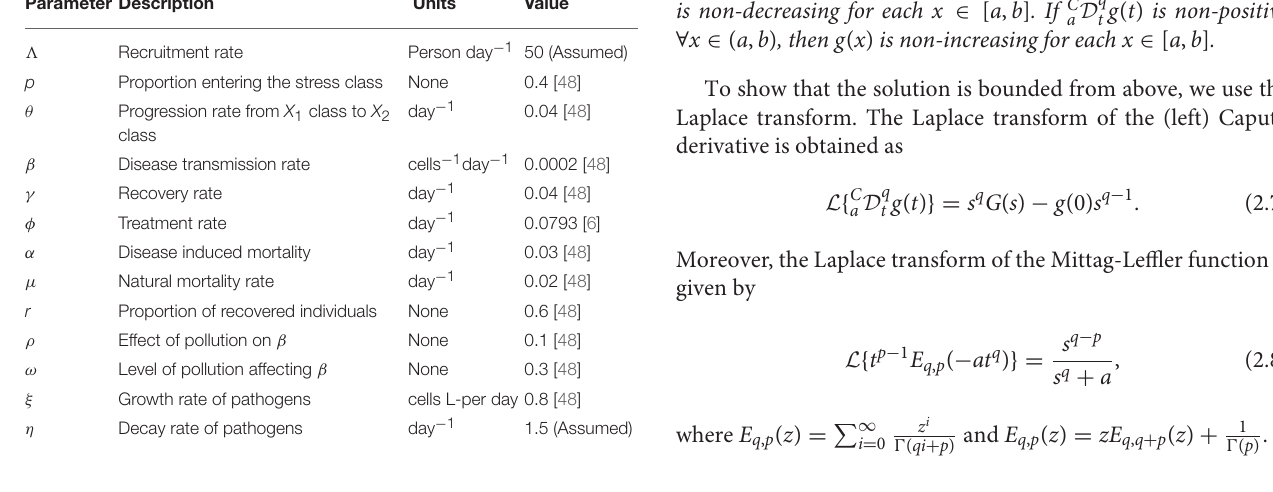
TABLE 1 | Parameter values. Parameter Description